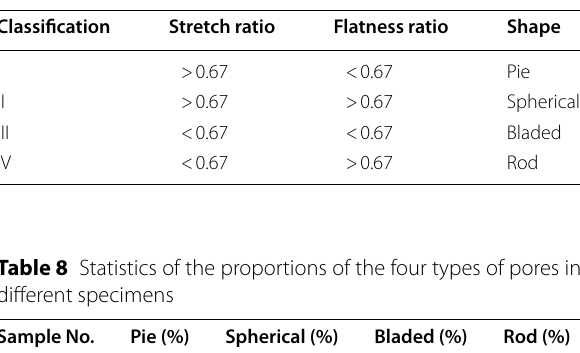
Table 7 Classification of shape factor index